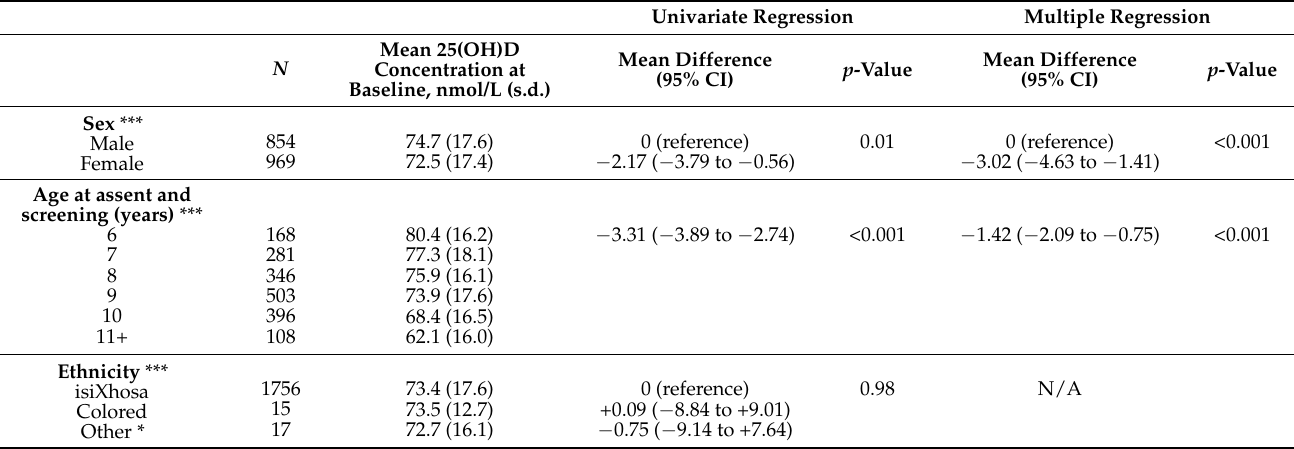
Table 1. Determinants of mean 25(OH)D concentration: univariate and multiple linear regression analysis. Univariate Regression Multiple Regression